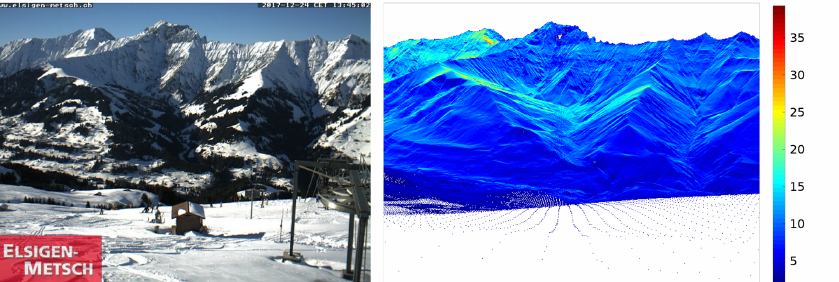
Figure 13. Example of projected pixel resolution for a webcam image at Metschalp (© elsigen-metsch.ch). Digital elevation model (DEM) data: swissALTI 3D , © swisstopo.